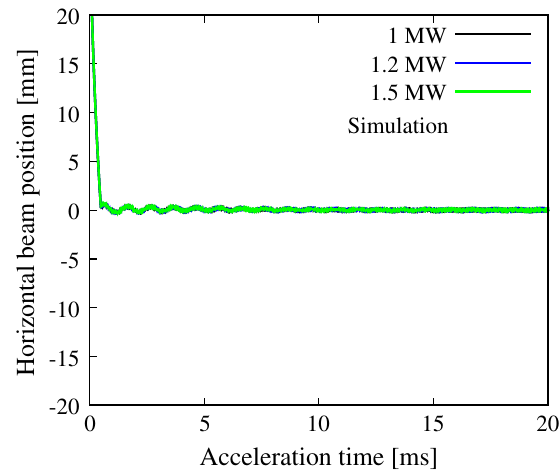
FIG. 27. Simulated results of beam centroid growth for beam powers of 1 (black line), 1.2 (blue line), and 1.5 MW (green line) employing reduced KM impedances by nearly a half. Beam powers beyond 1 MW can also be stabilized even with fully corrected ξ at the injection energy by using the SX dc × 1